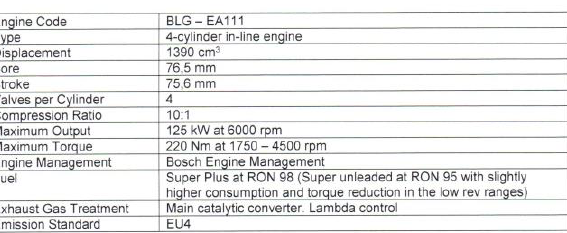
Table 1. Basic technical parameters of VW EA111 BLG